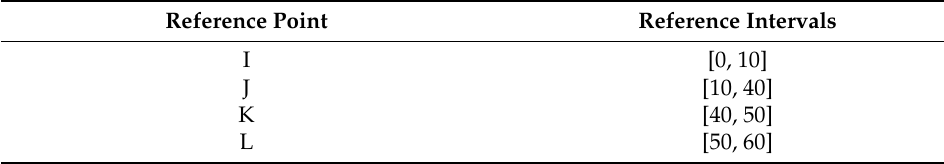
Table 8. Reference point and reference interval of premise attribute 2.